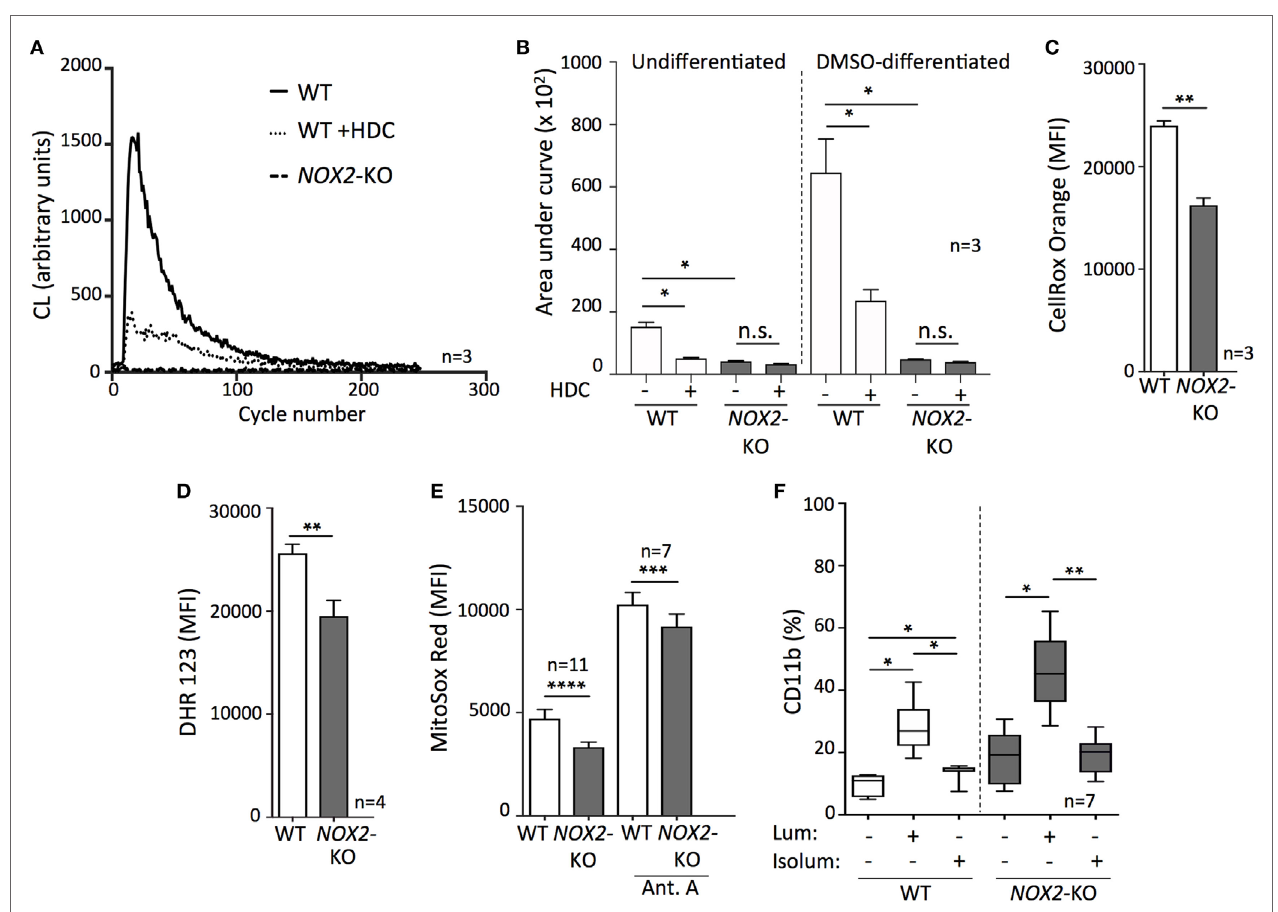
FigUre 2 | Targeting intracellular reactive oxygen species (ROS) promotes leukemic cell differentiation. (a,B) Measurement of ROS production by chemiluminescence following fMLF stimulation in the presence or absence of histamine dihydrochloride. (a) A representative curve showing the respiratory burst by dimethyl sulfoxide (DMSO)-differentiated wild-type (WT) or NOX2 -KO PLB-985. (B) ROS production by undifferentiated and DMSO-differentiated WT or NOX2 -KO PLB-985 cells. (c–e) Fluorescent measurement of intracellular ROS in WT and NOX2 -KO PLB-985 using flow cytometry: (c) cytoplasmic ROS, and (D,e) mitochondrial ROS. Antimycin A was used to trigger mitochondrial ROS production. (F) WT and NOX2 -KO PLB-985 cells were cultured in the presence or absence of luminol or isoluminol for 5 days and the percentage of CD11b + cells was determined by flow cytometry. Two-tailed paired or unpaired t -tests, one-way ANOVA; * p < 0.05, ** p < 0.01, *** p < 0.001, **** p <